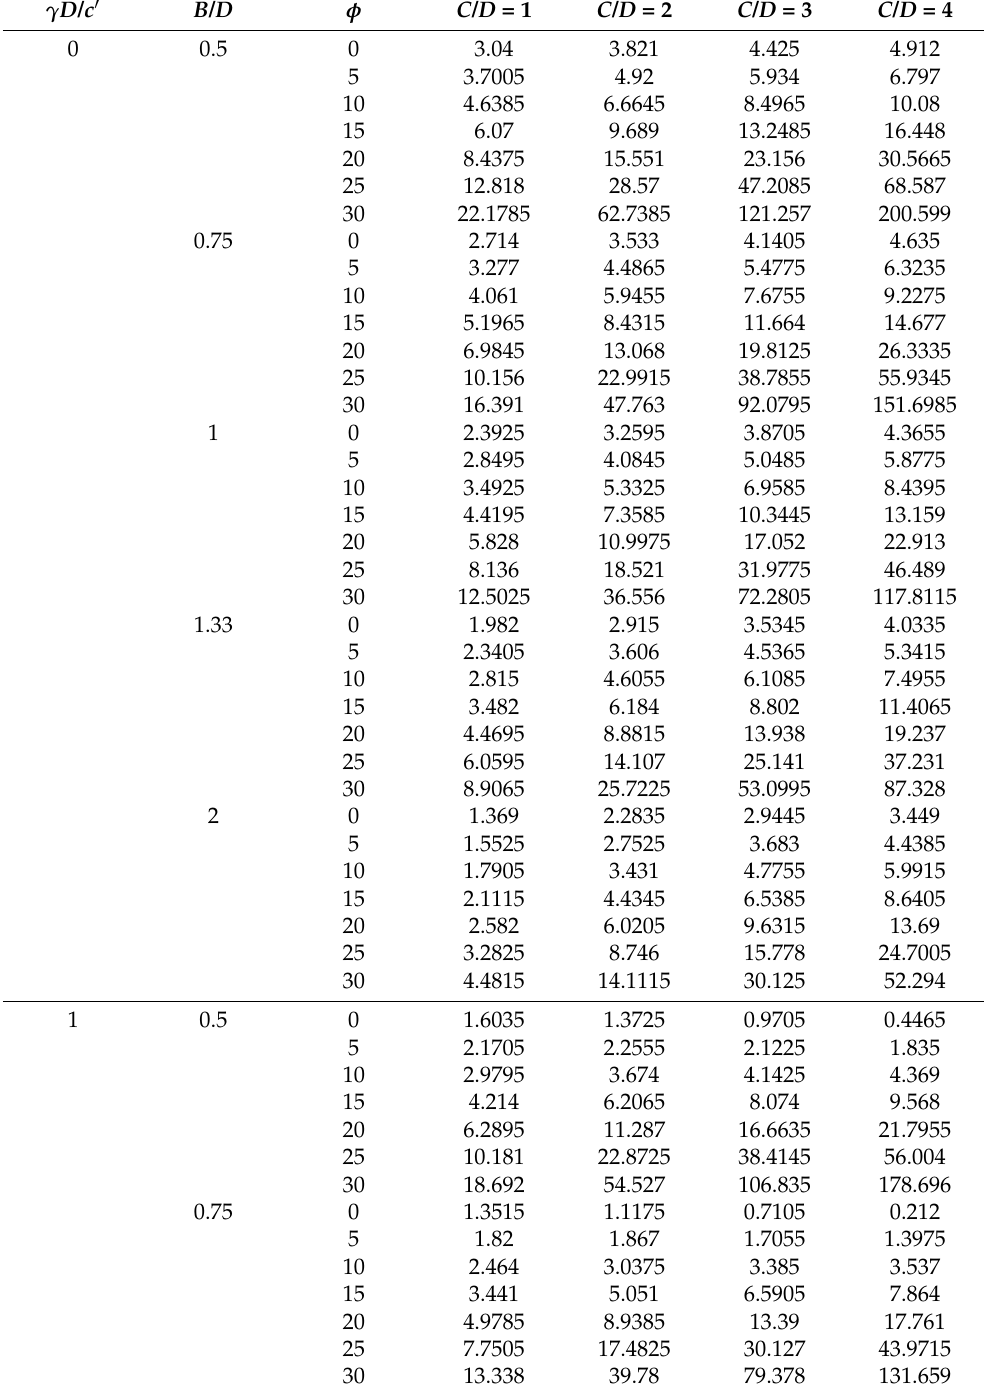
Table 2. Stability factor σ s / c (cid:48) for horseshoe